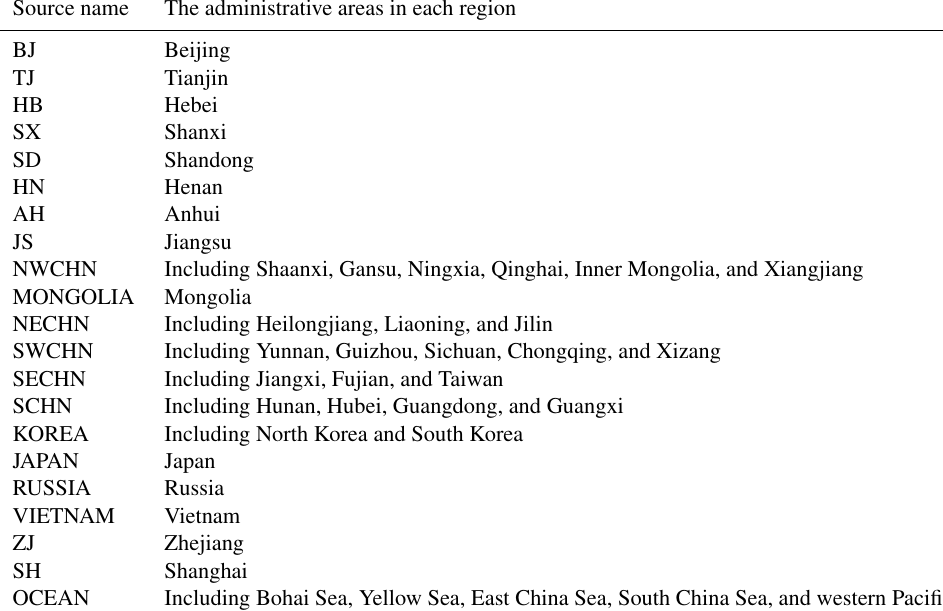
Table 1. Source region division.